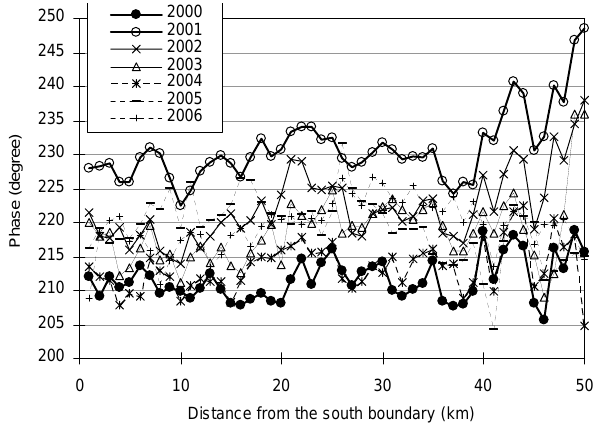
Fig. 13. Column-average of phase values of 12-month Fourier harmonic component of year N versus row, i.e. S-N transect of oasis for each year N.